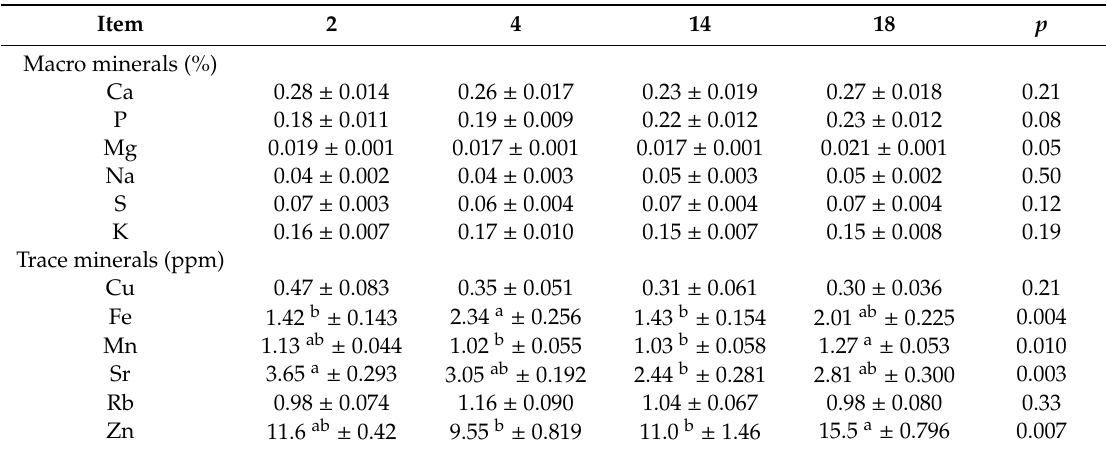
Table 4. E ff ects of lactation week on milk mineral composition of Iberian red deer hinds fed a balanced diet. Data are means ± standard error of mean 1